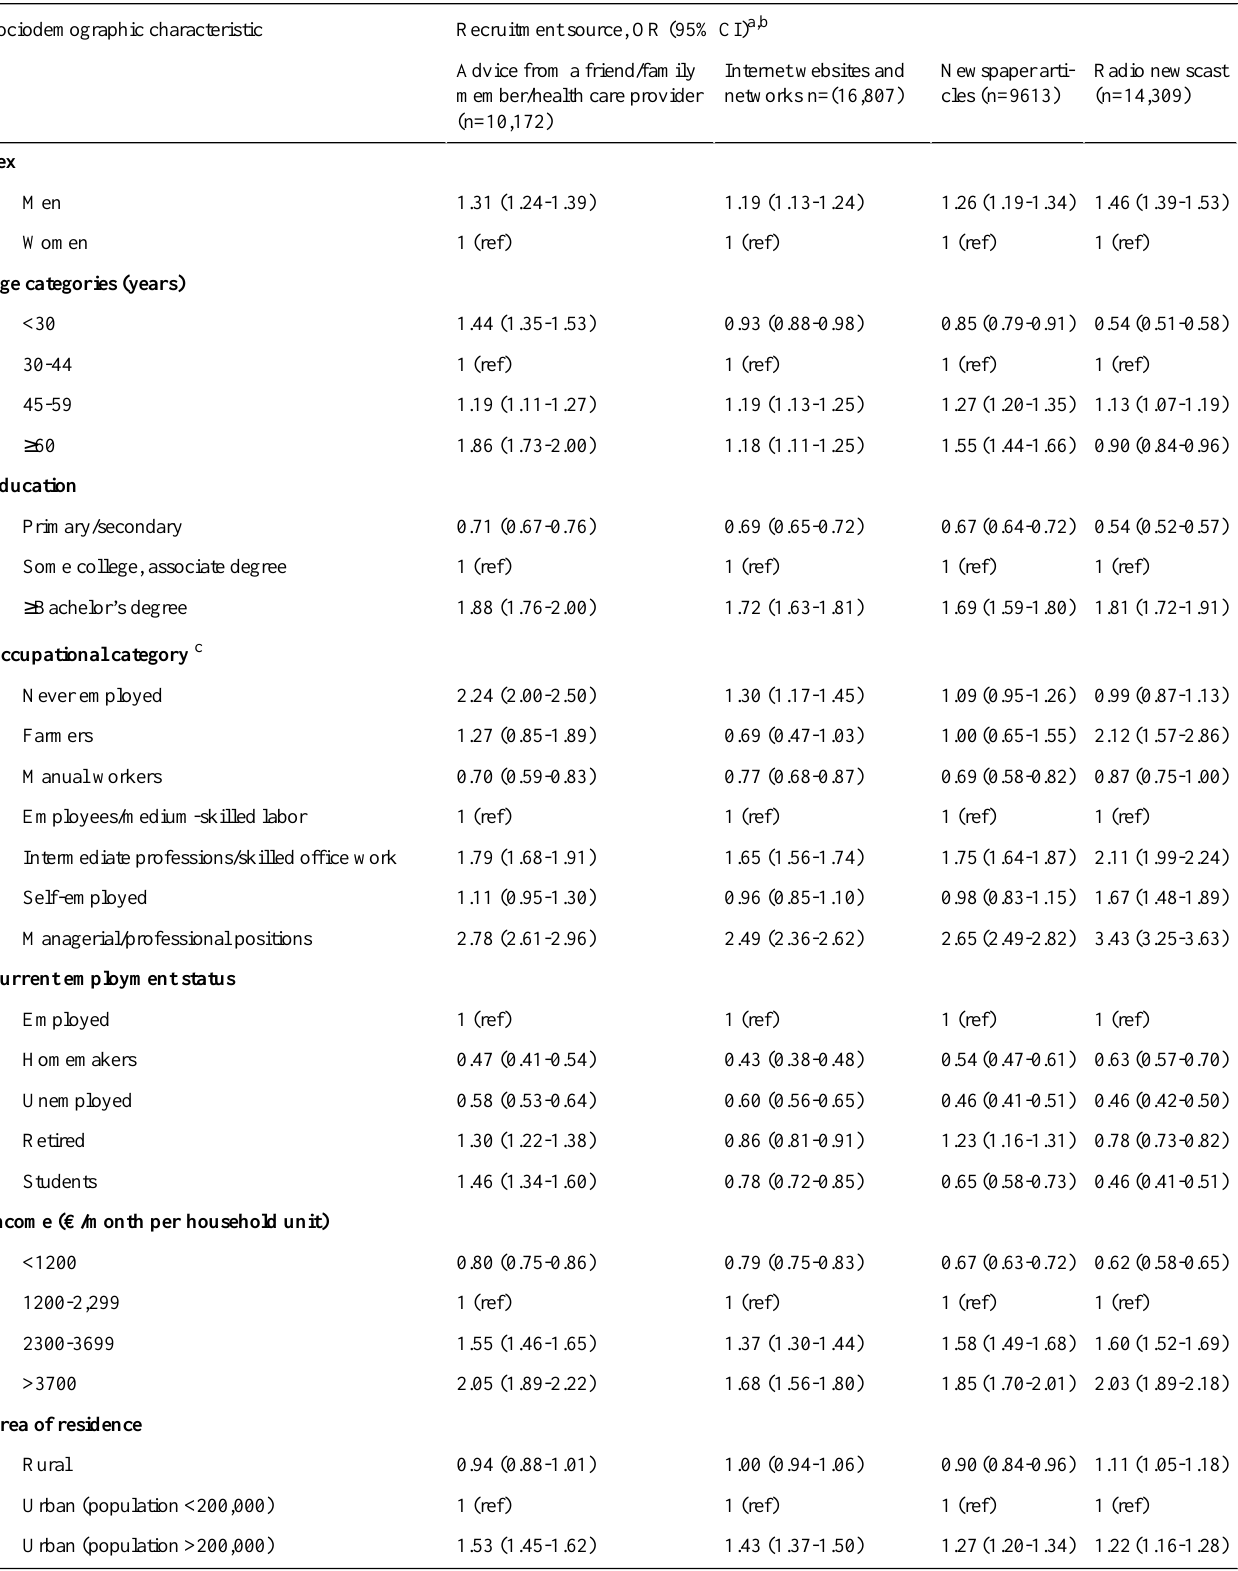
Table 2. Crude associations between sociodemographic profiles and recruitment source using television as reference (n=72,264).